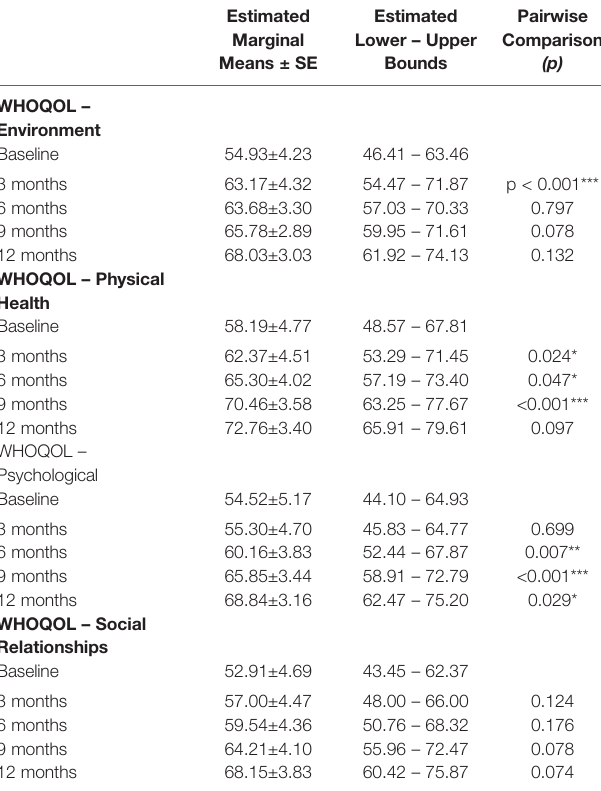
TABLE 3 | WHOQOL-BREF within-subjects pairwise comparisons; signi fi cance between successive time-points;* p < 0.05; ** p < 0.01; *** p < 0.001.